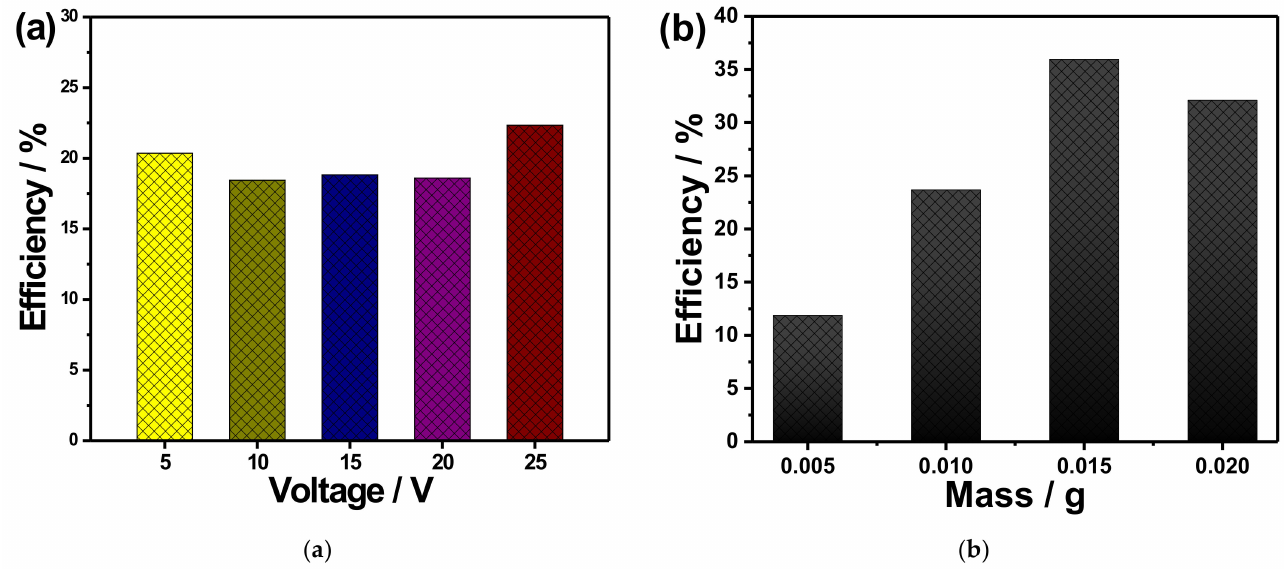
Figure 5. ( a ) Dye decolorization efficiency of MB after irradiation for 380 min, using anodized copper foams as a catalyst (anodized at various anodizing voltages), and ( b ) dye decolorization efficiency of MB after irradiation for 100 min, using various loaded masses of anodized copper foams at 25